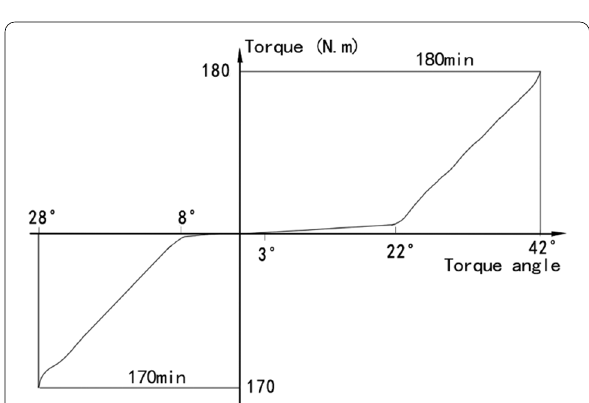
Figure 8 Graph showing torsion performance of wide-angle low-stiffness